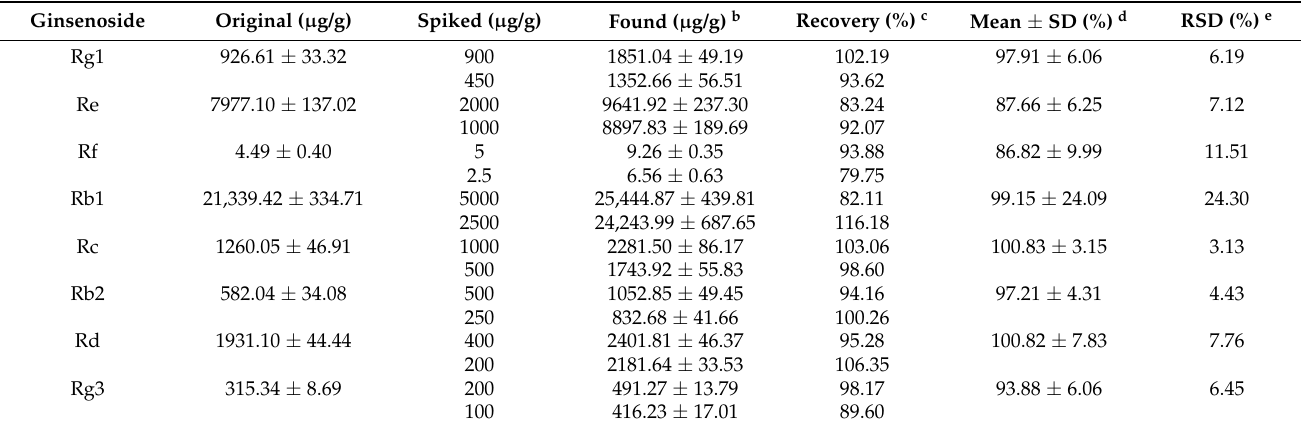
Table 7. The recovery data of ginsenosides by UPLC-HRMS-MS/MS a